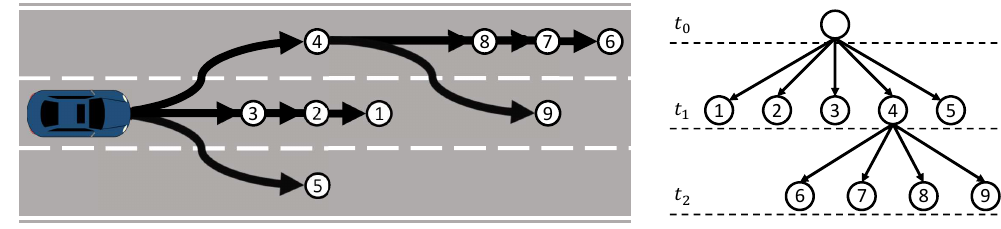
Figure 2. Structure of the search